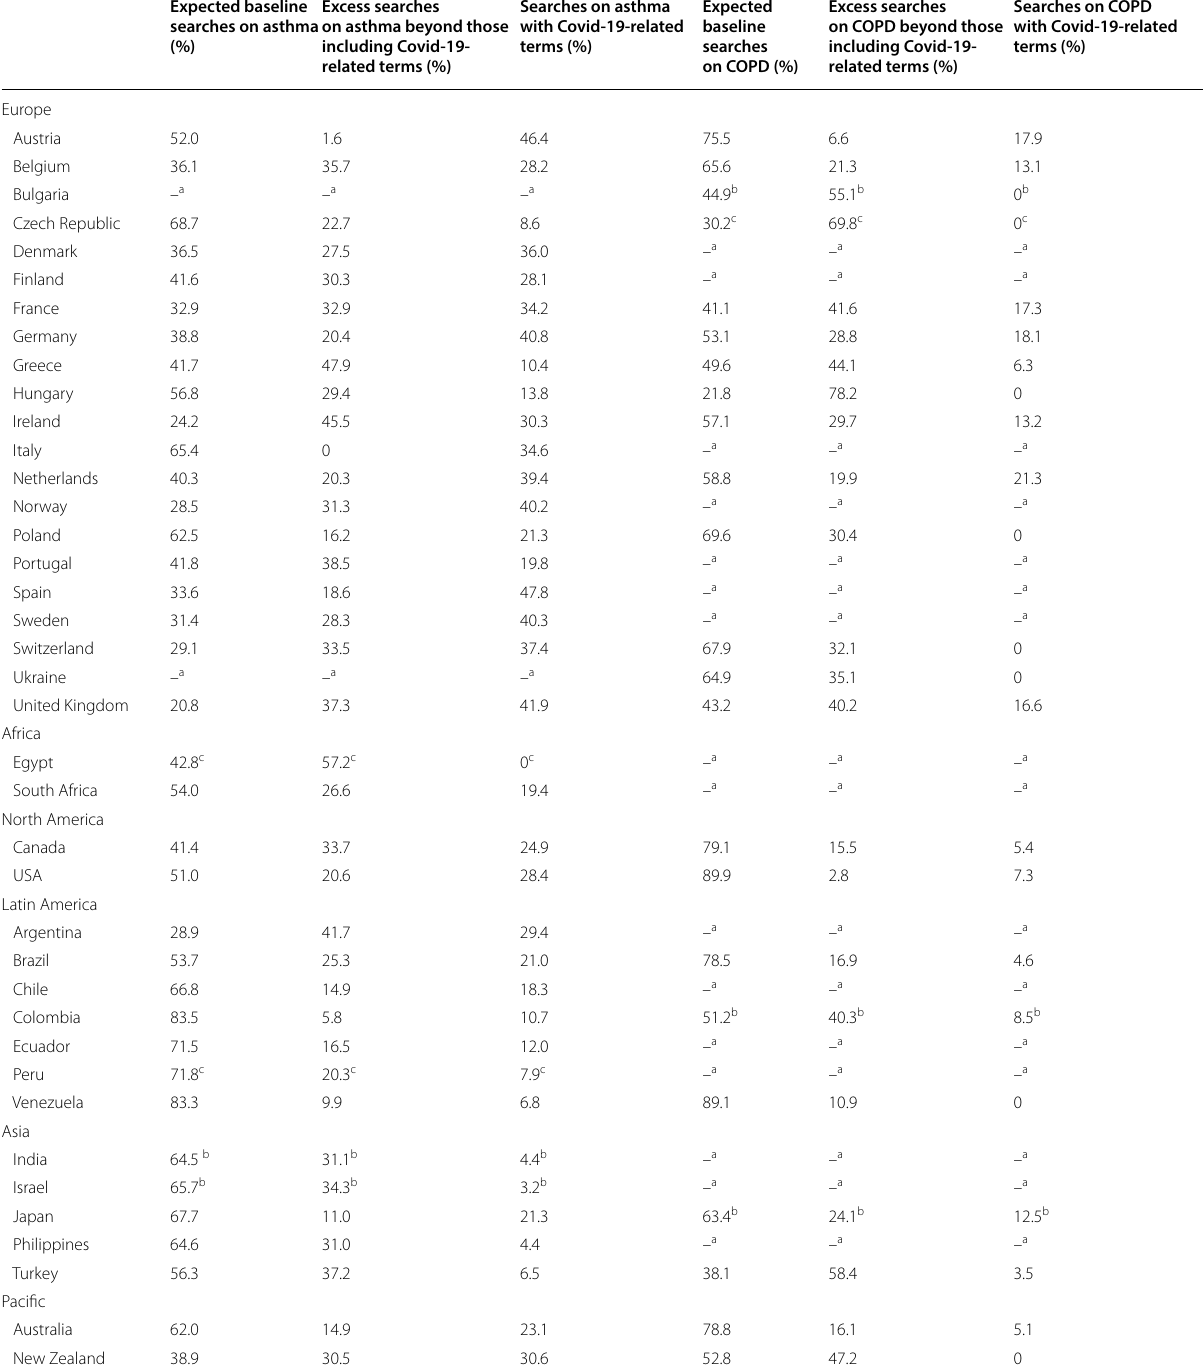
Table 3 Expected and excess Google Trends on asthma and chronic obstructive pulmonary disease